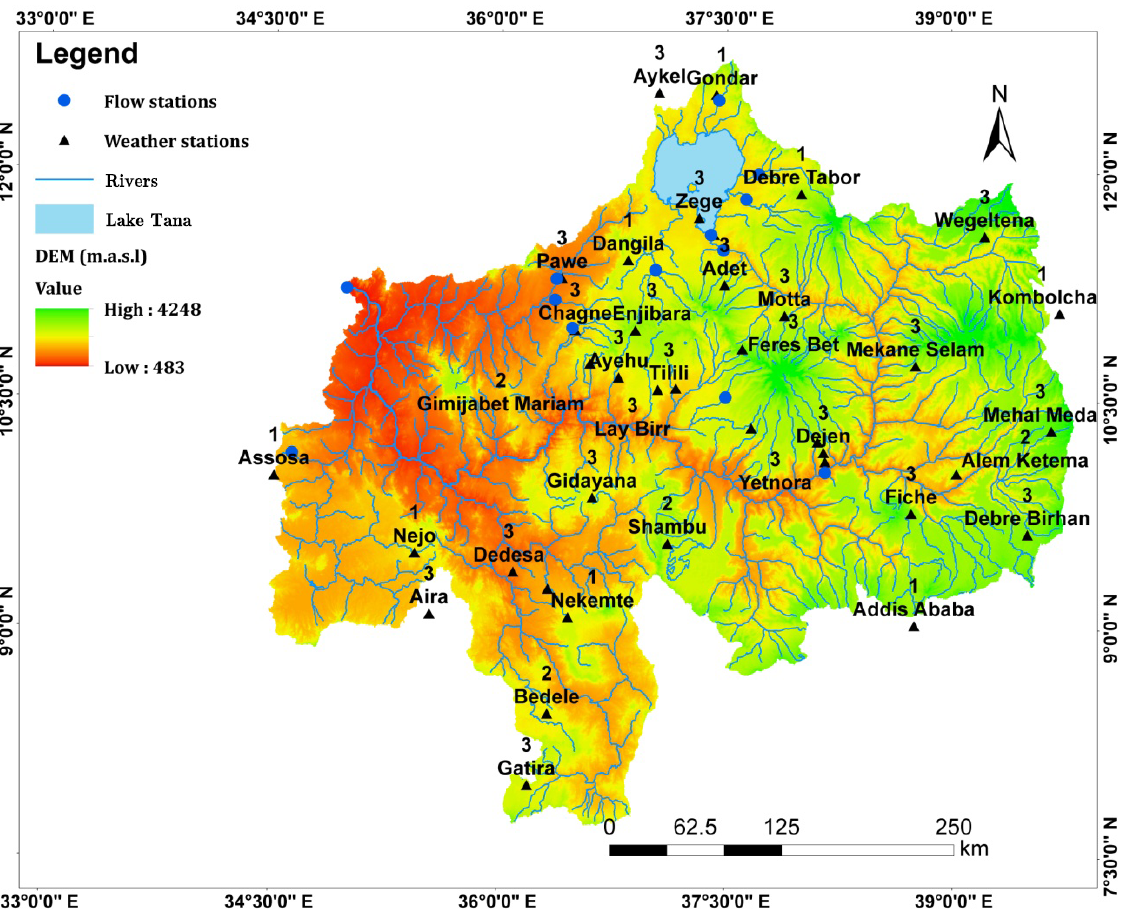
Figure 1. Locations of study area and meteorological and discharge stations, with the digital elevation model (DEM) data as the background (where 1 denotes stations used for SWAT model, 2 denotes stations used for trend analysis, and 3 denotes stations removed from the analysis). Table 1. The UBNRB’s areal long-term (1971–2010) mean annual and seasonal rainfall and streamflow. Amount Contribution (%) Station Kiremit Belg Bega Total Kiremit Belg Bega Mean Area (km 2 ) Flow (m 3 s − 1 ) 3506.3 300.4 1018.4 Rainfall (mm)